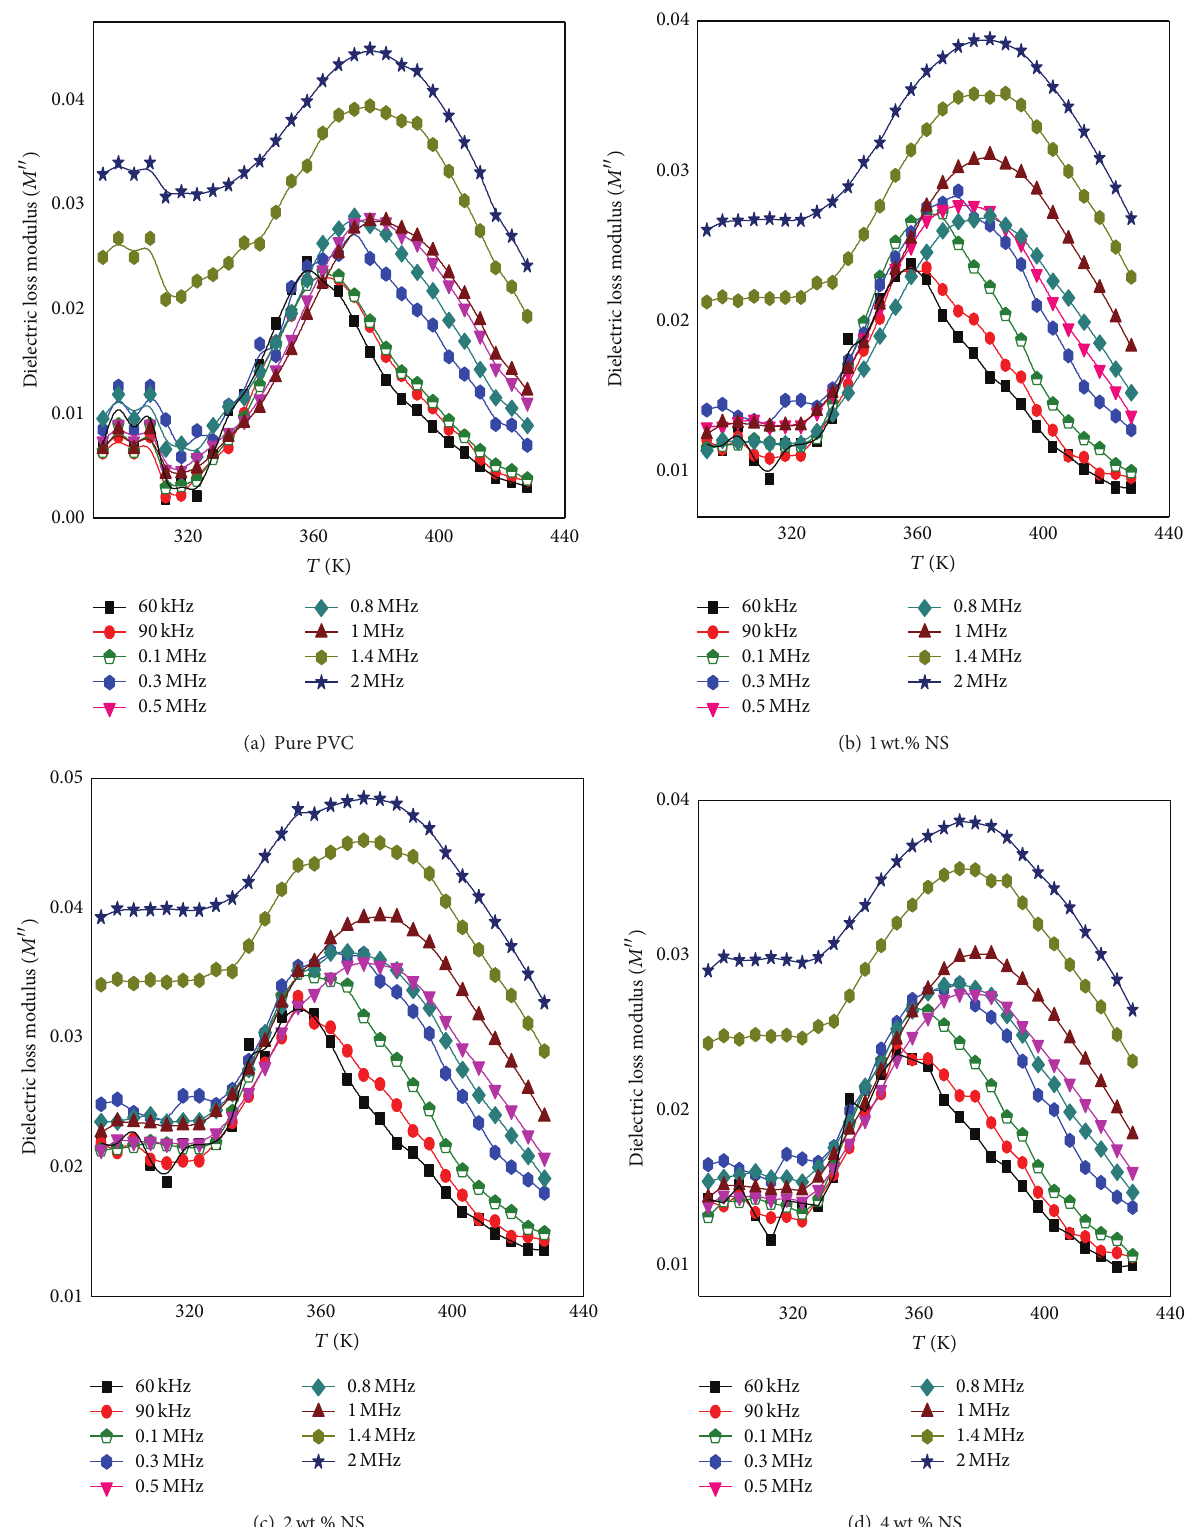
Figure 11: The variation of dielectric modulus, 𝑀 󸀠󸀠 , for pure PVC and PVC-SiO 2 nanocomposite films with temperature at different